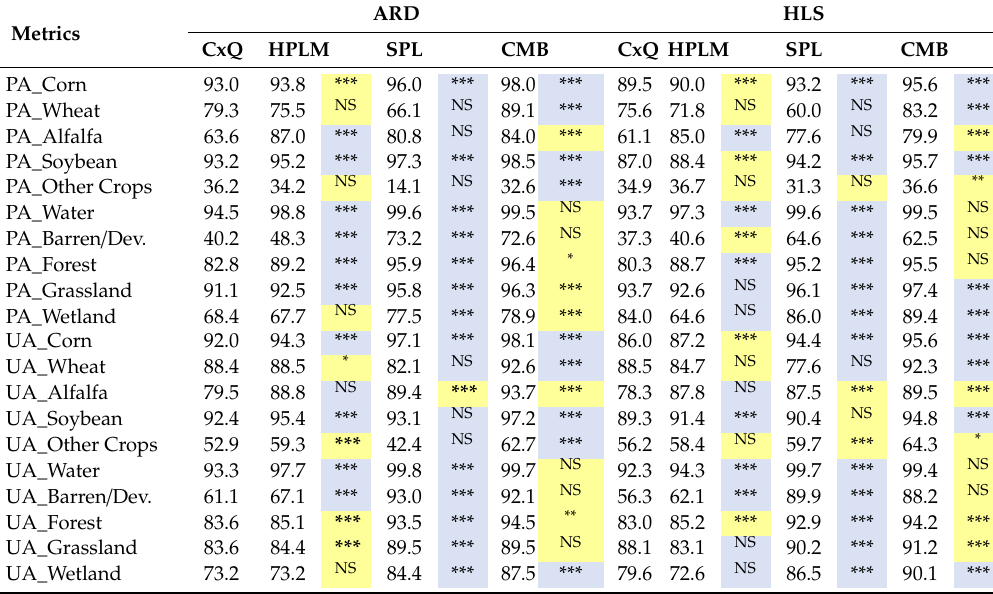
Table 8. PA / UA in percent (%) of 2016 RFC models summarized by sets of input variables. A certain scenario (current column) was compared to a scenario on the left (left column) using nonparametric Mann–Whitney U and TOST equivalence tests. The null hypothesis of the U test is that a random accuracy metric of the first scenario (left column) will be less than a random accuracy metric of the second scenario (current column). Significance levels of the U test are indicated by ***, **, and * for p-values of less than 0.001, 0.01, and 0.05, respectively. NS stands for “not significant”. Results of TOST equivalence tests are highlighted in light blue for “not equivalent” and light yellow for